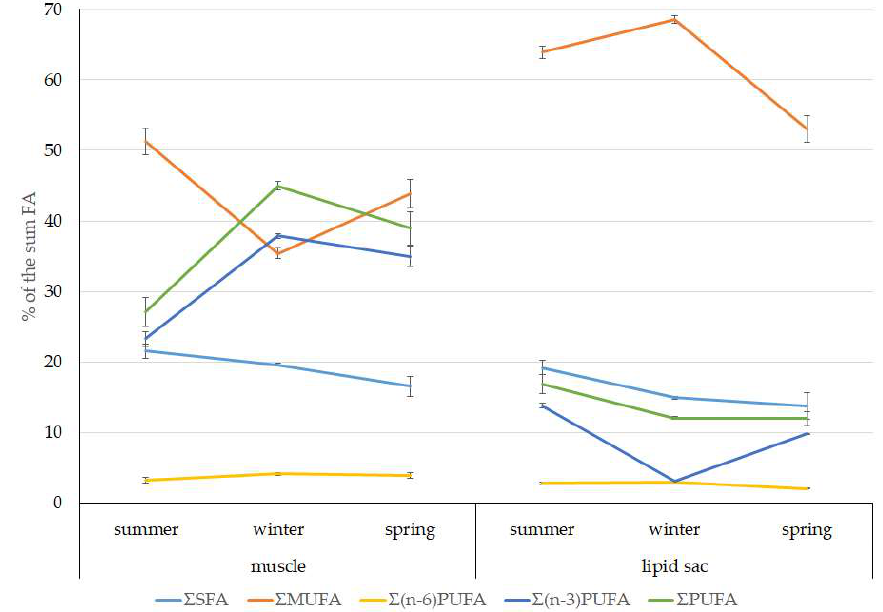
Figure 6. Seasonal dynamic of the saturated FA (SFA), monounsaturated FA (MUFA), polyunsaturated FA (PUFA) levels, including (n-3)PUFA and (n-6)PUFA (% of the sum of FAs) in muscle and the lipid sac in postlarval (L3 developmental stage) daubed shanny from Kongsfjord. The data presented as M ± SE.